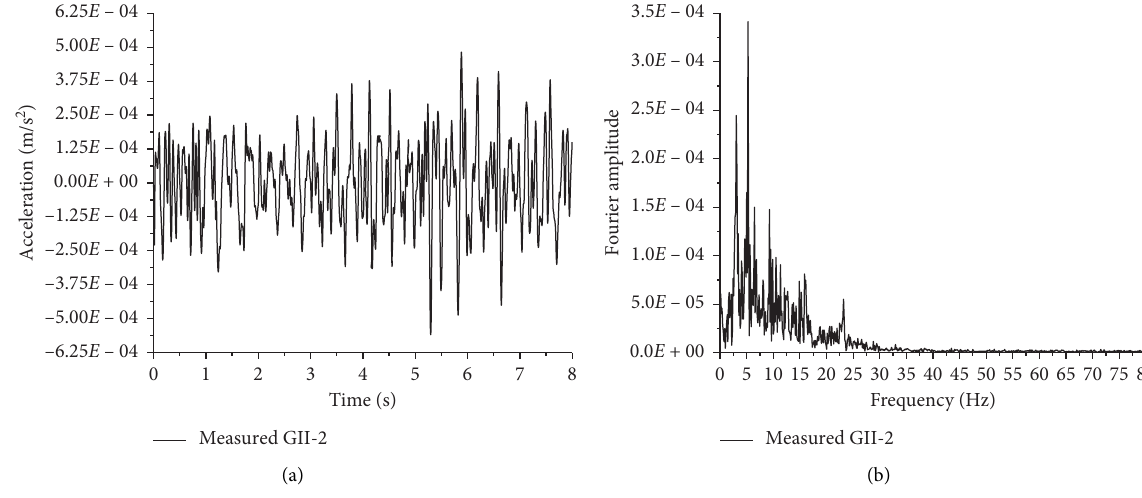
Figure 14: Acceleration: (a) time history and (b) frequency spectrum of